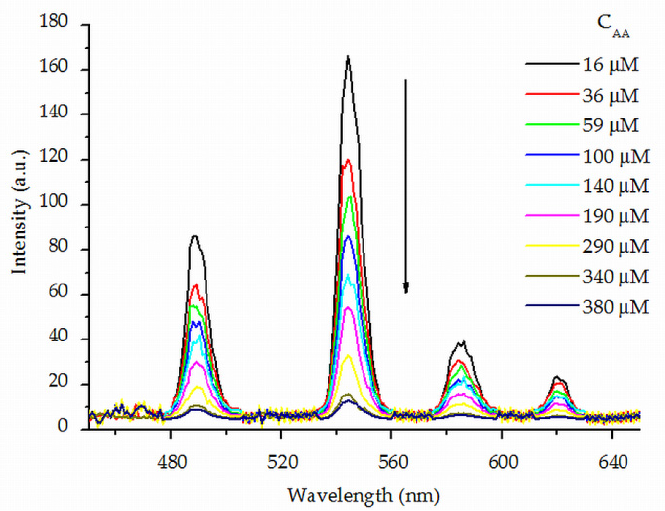
Figure 6. Fluorescence spectra of the Tb(Phen) complex with various additives of ascorbic acid (pH = 7). Figure 7 illustrates a Stern–Volmer plot for fluorescence quenching of Tb(Phen) by ascorbic acid. The fluorescence intensities were measured at λ = 544 nm.